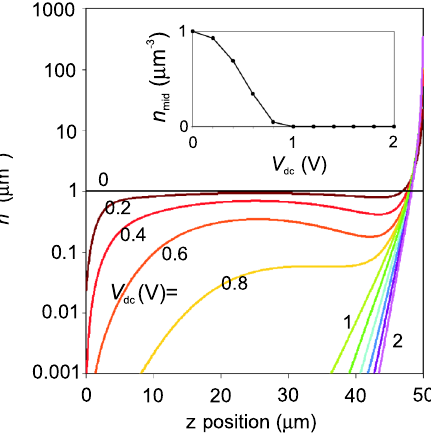
FIG. 9. Simulation of the concentration distribution of posi- tively charged micelles (similar for negatively charged micelles) for (cid:1) n ¼ 1 (cid:1) m (cid:1) 3 while the voltage V dc is increased stepwise by 0.2 V every 4 s. The concentration profiles are shown at the end of each 4-s time interval. The electrodes are situated at z ¼ 0 and 50 (cid:1) m . For voltages below 1 V, the concentration profiles are not in the steady state. At voltages below 0.2 V, the bulk concentration remains approximately the same as (cid:1) n . For voltages around 0.8 V, the concentrations of positively and negatively charged micelles in the middle become much lower. Above 1 V, the micellar ions are fully separated. In the inset, the concentra- tion n mid of positively and negatively charged micelles in the midplane between the electrodes (at z ¼ 25 (cid:1) m ) is shown as a function of V dc